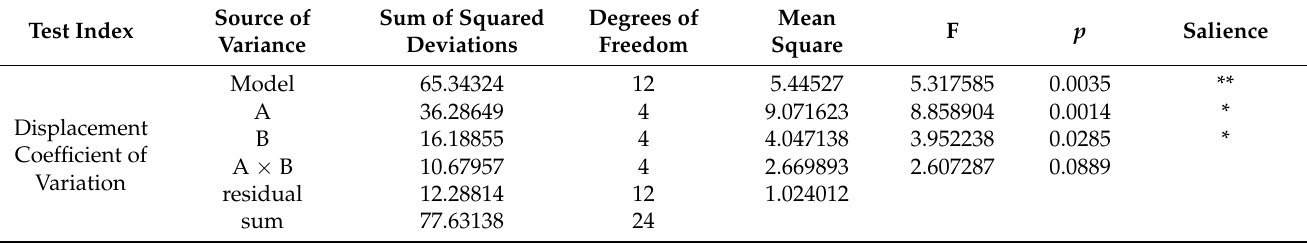
Table 6. Variance analysis of test: “**” indicates extremely significant, and “*” indicates